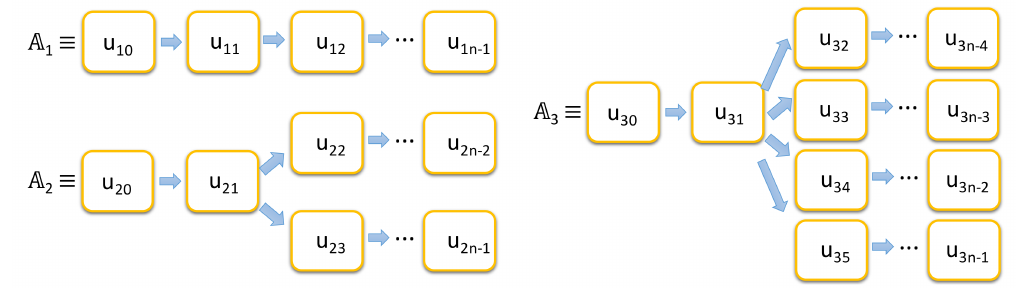
Figure 1. Diagram of different flow possibilities in our proposed distributed system.